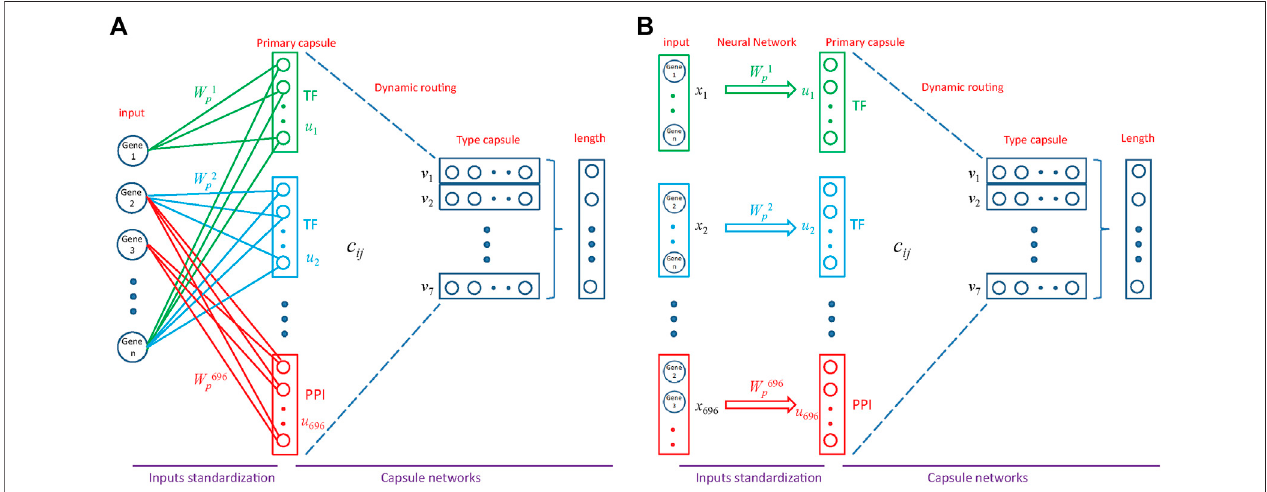
FIGURE 4 | The comparison between MultiCapsNet and feed forward neural network shows the high performance and interpretability of MultiCapsNet. (A) The AUC scores demonstrate that the MultiCapsNet model achieves very high classi fi cation performances in all three classi fi cation categories. (B) The normalized group (data source) importance scores generated by MultiCapsNet and feed forward neural network are highly